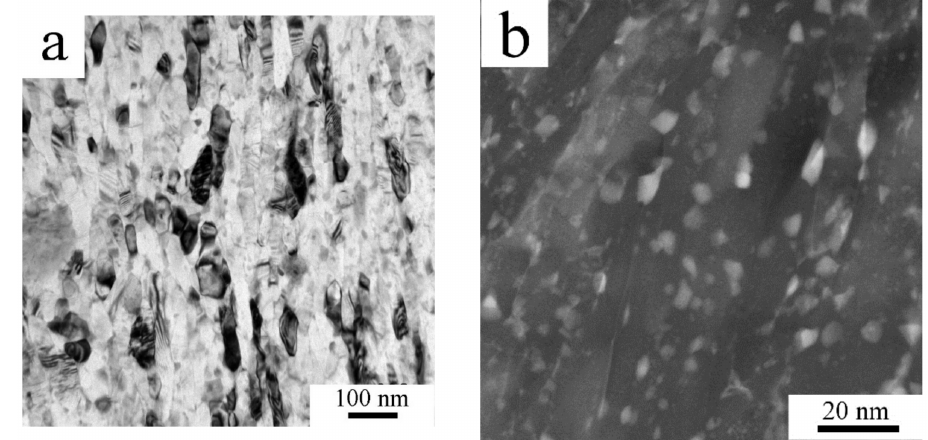
Figure 4. The microstructure of the milled powder, Al7075_M: ( a ) elongated grains, transmission electron microscopy (TEM) and ( b ) nanometer-sized second phase particles,